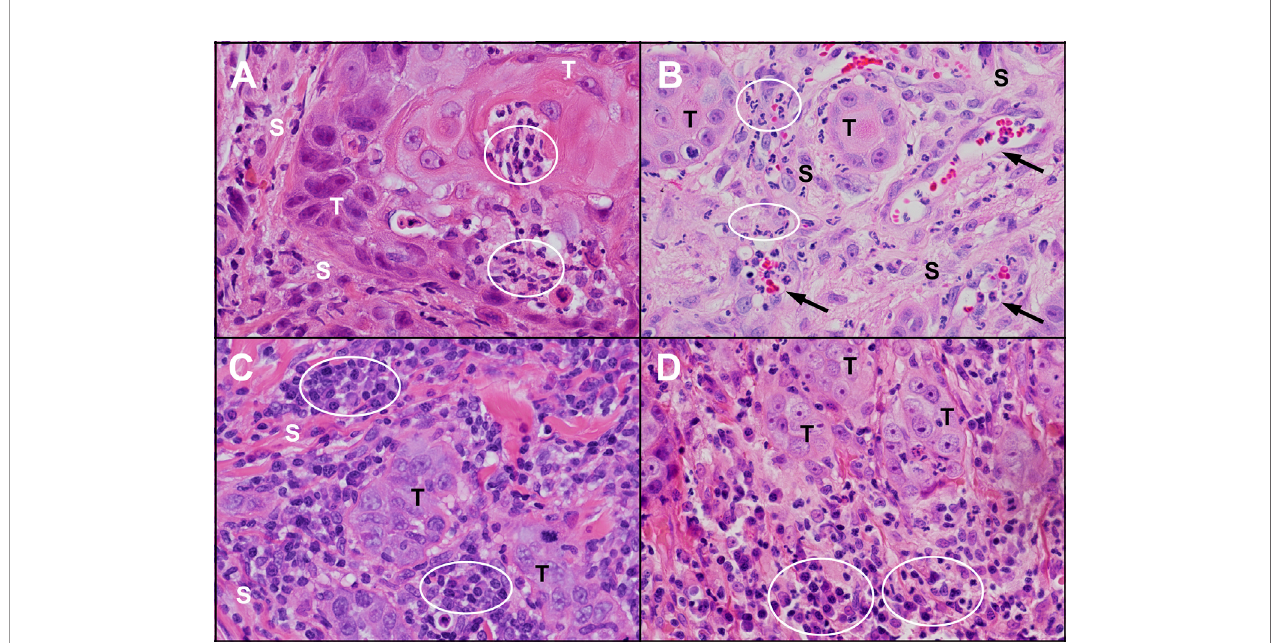
FIGURE 4 | In fl ammation in untreated human and feline OSCC. (A) An island of human OSCC tumour cells (T) embedded in stroma (S) with in fi ltrating neutrophils (circles). (B) Islands of feline OSCC tumour (T) with neutrophils (circles) in fi ltrating the tumour stroma (S) and within small blood vessels (arrows). (C) Small islands of human OSCC tumour cells (T) surrounded by numerous lymphocytes and plasma cells (circles). (D) Small islands of feline OSCC tumour cells (T) associated with mixed in fl ammatory in fi ltrates composed of plasma cells, lymphocytes and neutrophils (circles). (haematoxylin and eosin stain, 40X